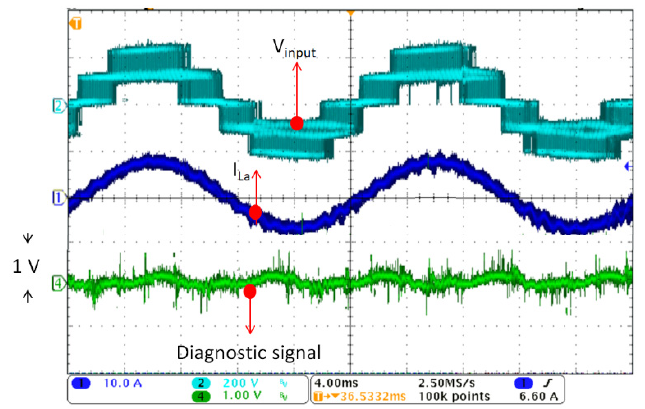
Figure 17. Steady state waveforms at 3 kW.